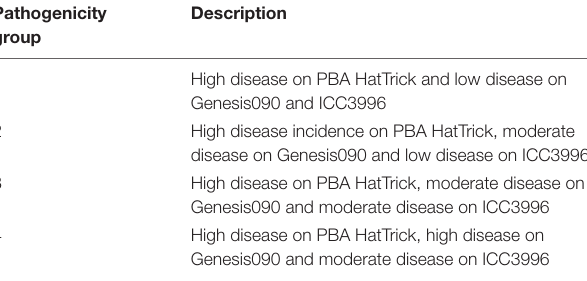
TABLE 2 | Criteria used for pathogenicity grouping of the highly aggressive isolates. Pathogenicity